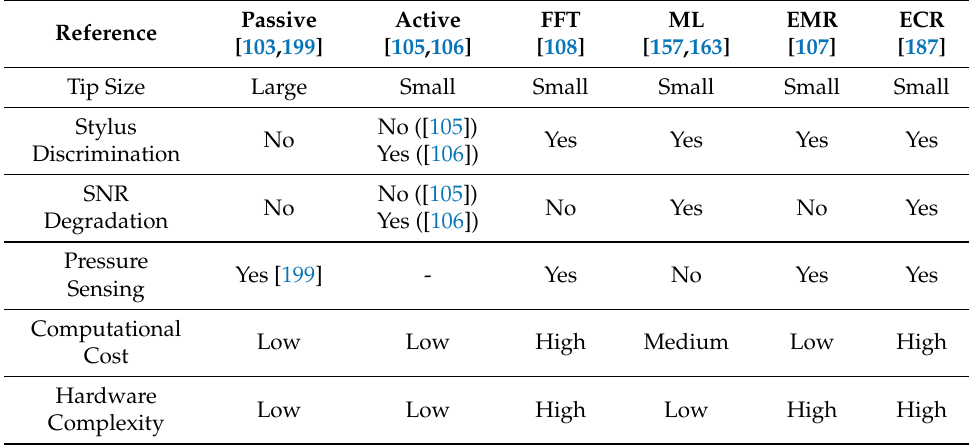
Table 3. Comparison of stylus technologies for capacitive